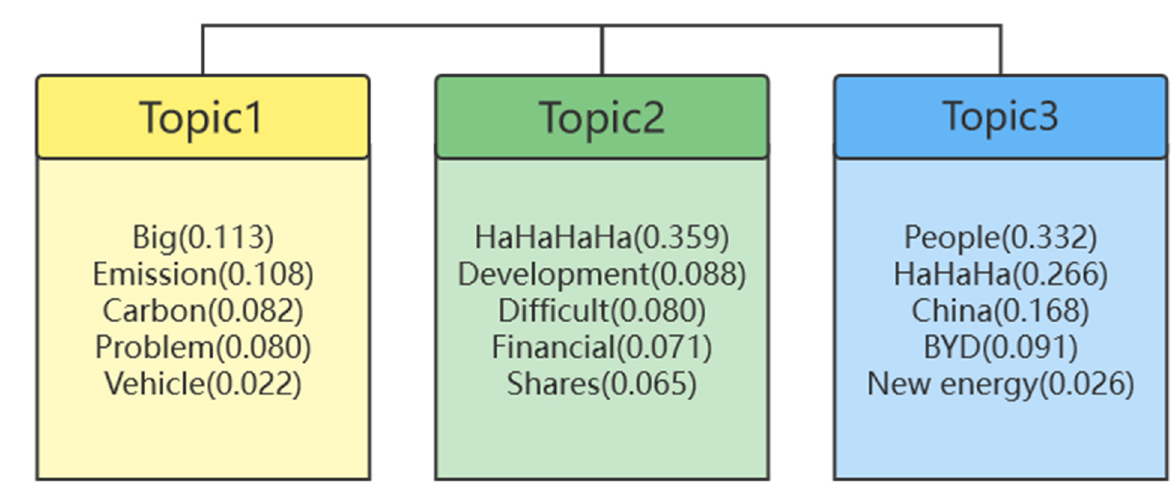
Figure 3. The topics and corresponding feature words.